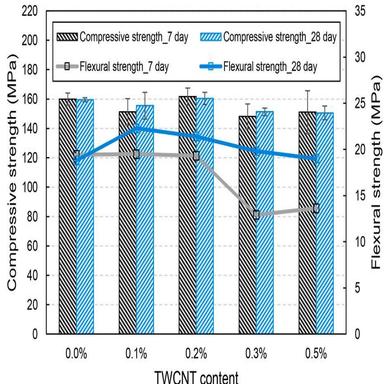
Compressive and flexural strengths of the samples.